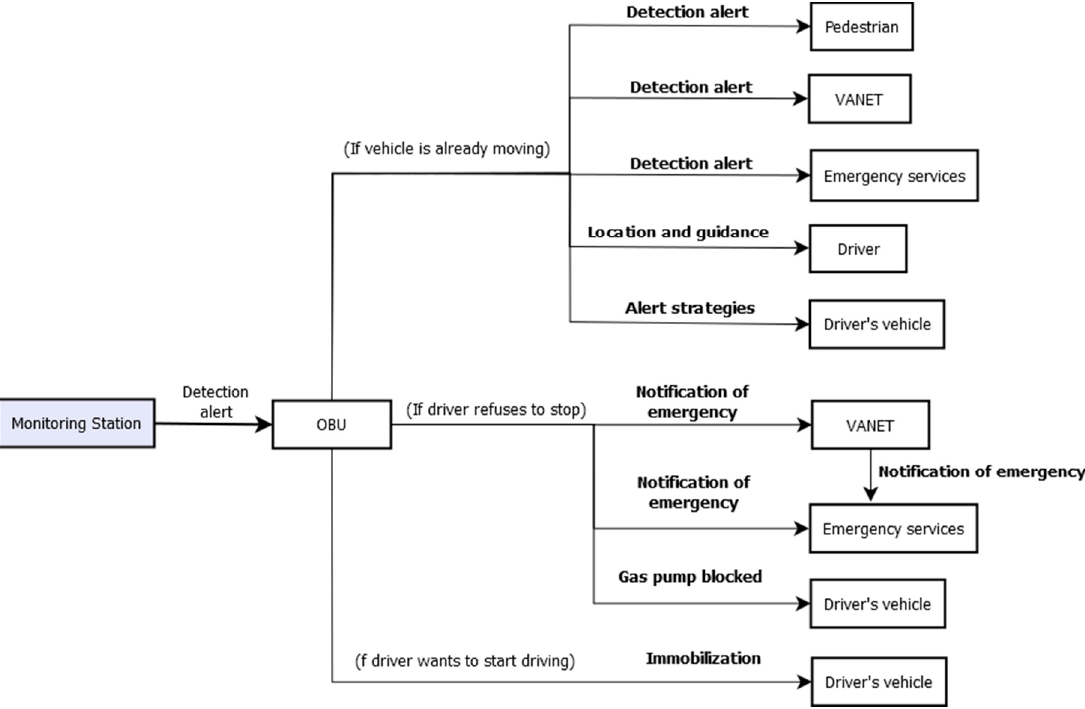
Figure 4. Enforcement points.